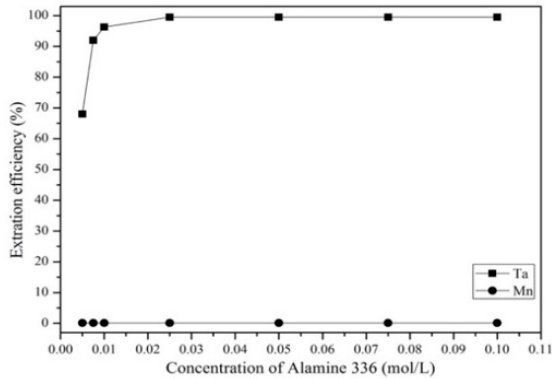
Figure 10. E ff ect of di ff erent concentrations of Alamine 336 on the extraction e ffi ciency. pH = 1. Extraction time: 5 min. A / O =